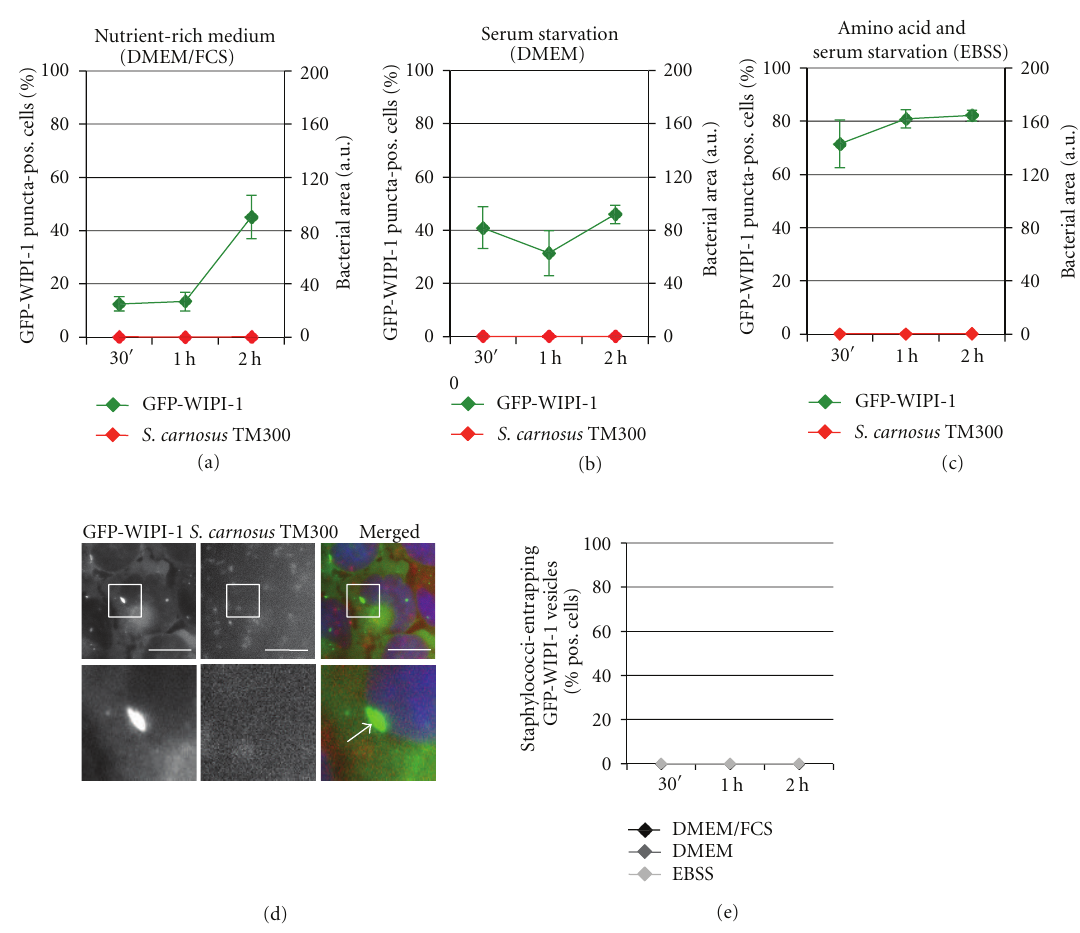
Figure 7: Apathogenic S. carnosus TM300 cells are not entrapped in GFP-WIPI-1 positive autophagosome-like vesicles. According to Figures 4–6, GFP-WIPI-1 U2OS cells were infected with mCherry-expressing S. carnosus TM300 in DMEM/FCS (a), DMEM (b), and EBSS (c) and analyzed (up to 2000 individual cells). Representative images (2h, DMEM/FCS) are presented ((d), scale bars: 20 μ m). The number of cells with GFP-WIPI-1 positive autophagosomal-like vesicles entrapping S. carnosus TM300 is presented (e) ± SD ( n = 2, each in